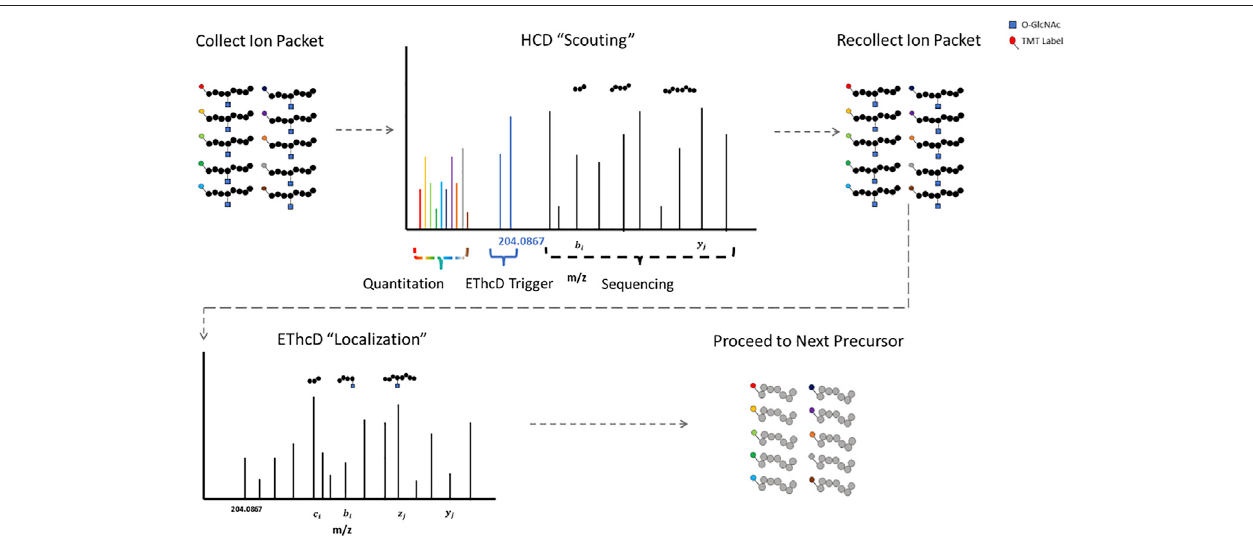
FIGURE 1 | HCD-pdt-ETD for HexNAc Modi fi ed Peptides HCD-pdt-ETD methods couple collisional activation and electron transfer dissociation methods for putativeO-GlcNAcmodi fi edprecursors.Precursorsare fi rstfragmentedwithHCD,whereupondetectionofaHexNAcfragmention(suchasthe204.0867),asecondary packet of ions of the same precursor is recollected and fragmented with ETD. ETD provides an alternative fragmentation method that may preserve the HexNAc modi fi cation, allowing for site localization. ETD fragmentation can proceed with whatever preferred supplemental energy technique applied. The HCD “ scouting ” scan may serve as a fi lter to only trigger ETD on highly suspect O-GlcNAcylated peptides. In future investigations, TMT quantitation may be foreseeably coupled to the HCD “ scout ”